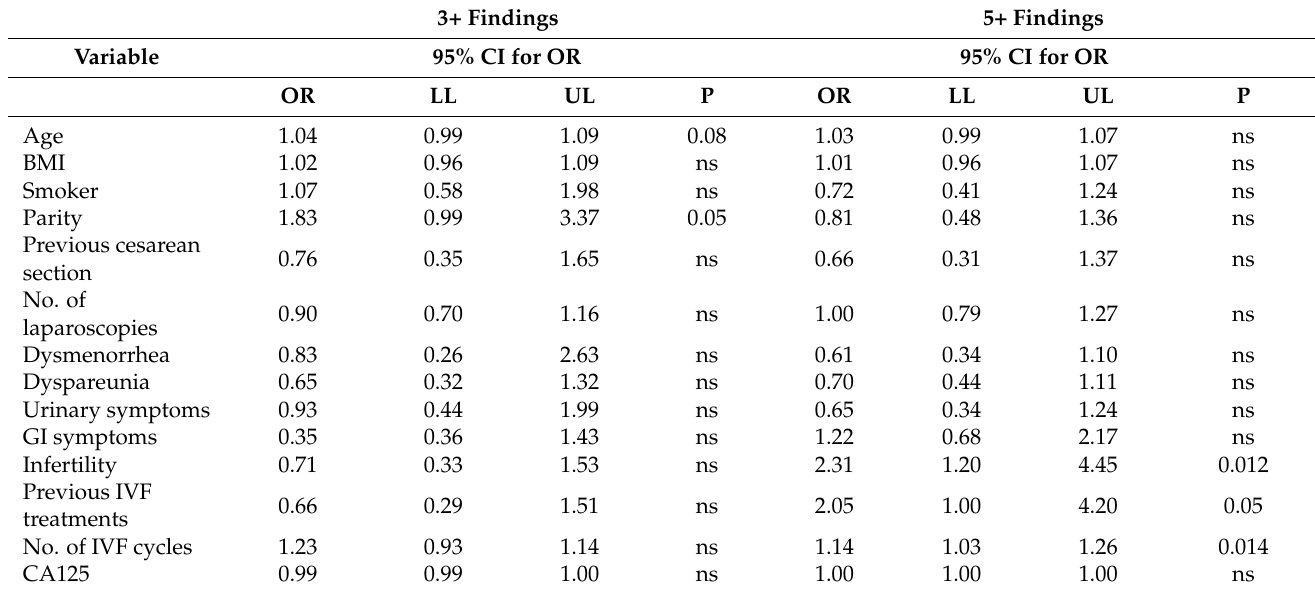
Table 4. Univariate analysis of the associations between demographic data, clinical symptoms, and the number of sonographic findings of adenomyosis in women undergoing surgery ( n =